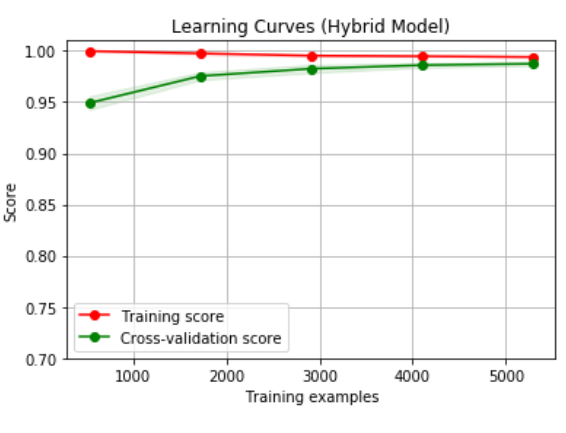
Figure 14. Training score (Number of training examples and its accuracy) vs Validation Score